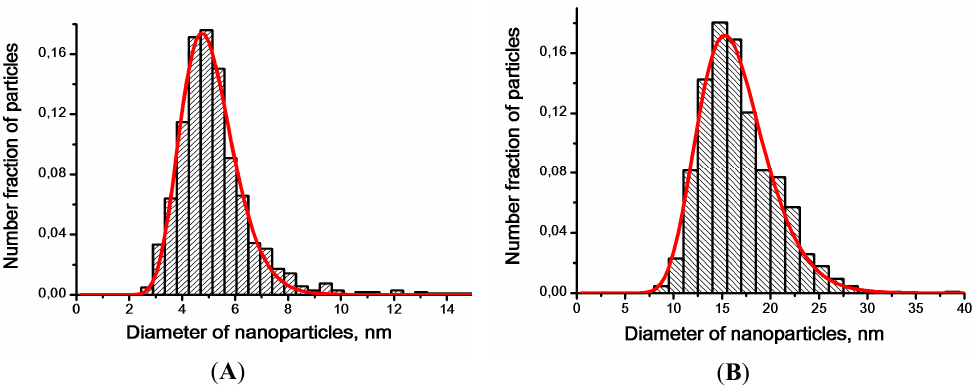
Figure 5. Particle size distribution of as-synthesized SnO 2 powder ( A ) and of the powder after annealing at 610 °C ( B ).